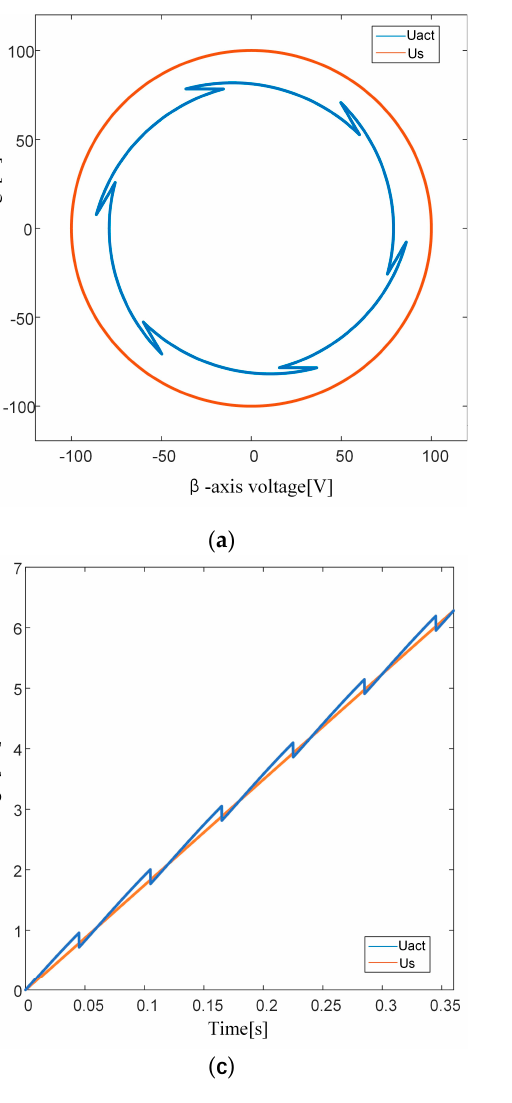
Figure 5. Waveform of dead time effect: ( a ) The ideal voltage and the actual voltage between α axis and β axis; ( b ) actual voltage amplitude; ( c ) the phase between the actual voltage and the ideal voltage; ( d ) actual phase voltage and ideal phase voltage.